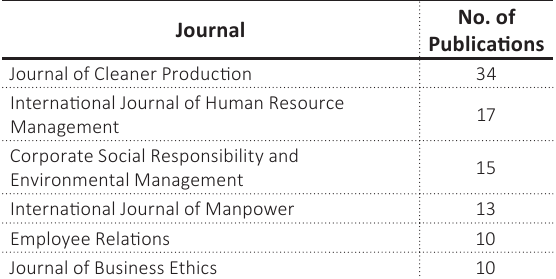
Table 1. Journals for Sustainable HRM